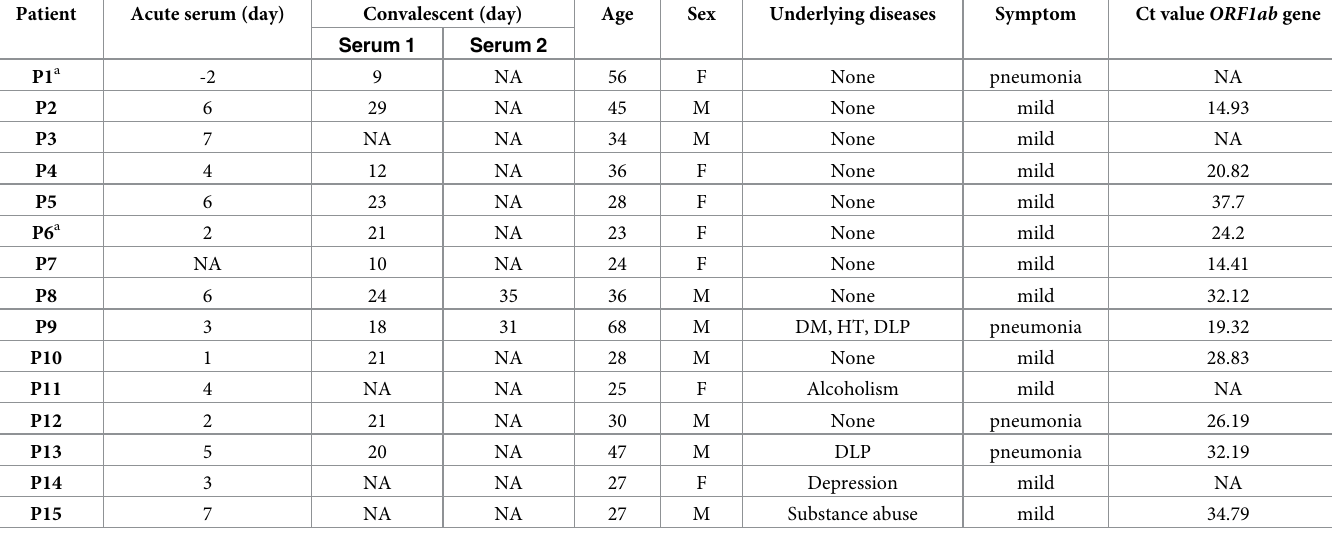
A total of 27 serum samples from 15 patients were analyzed with ELISAs measuring IgM, IgA and IgG specific for SARS-CoV-2 RBD in COVID-19 patients (Fig 1). The acute serum sam- ples were collected within the first week of admission from 14 patients with a median time of 4 days (IQR = 2–6). The convalescent serum from 11 patients was obtained during the treatment with a median time of 21 days (IQR = 18–24). We observed that 93% (13 of 14) of COVID-19 patients had IgM levels lower than the diagnostic threshold value of 1.05 at the acute phase with a median IgM level of 0.80 (IQR = 0.72–0.92, Fig 1A and S1 Table). We also observed low levels of IgA and IgG antibodies targeting RBD antigen at the first week of admission with a median level of 0.99 (IQR = 0.88–1.02) for IgA and a median level of 0.96 (IQR = 0.86–1.00) for IgG (Fig 1B, 1C and S1 Table). Furthermore, IgA and IgG levels were higher than IgM in the acute serum sample of COVID-19 patients ( P = 0.002 and P = 0.016, respectively). We then compared the antibody levels reacting against the RBD antigen in convalescent serum samples collected between admission and recovery periods in 10 patients who had Table 1. Patient demographics and clinical